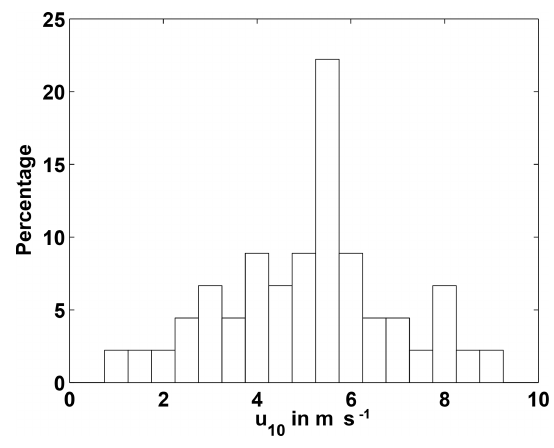
Figure 2. Histogram of rms averaged wind speed in December 2012 at stations where CTD − O 2 and N 2 O were sampled simultaneously. Averaging at maximum during 6h and in a radius of 5nm around the CTD